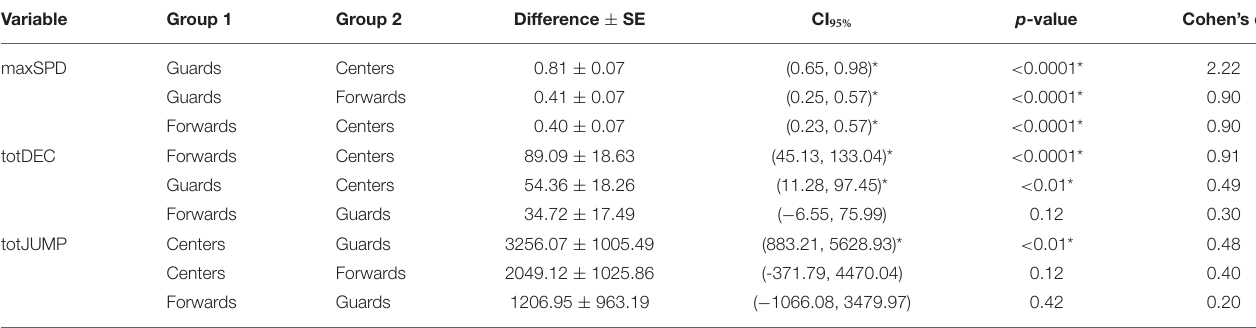
TABLE 4 | Tukey’s HSD post-hoc ordered differences pairwise comparisons for the external load demands of different player positions.